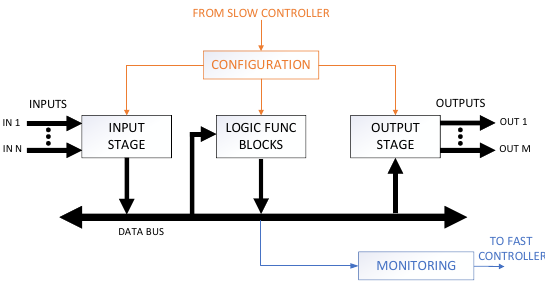
Fig. 4. Fast Protection Controller.